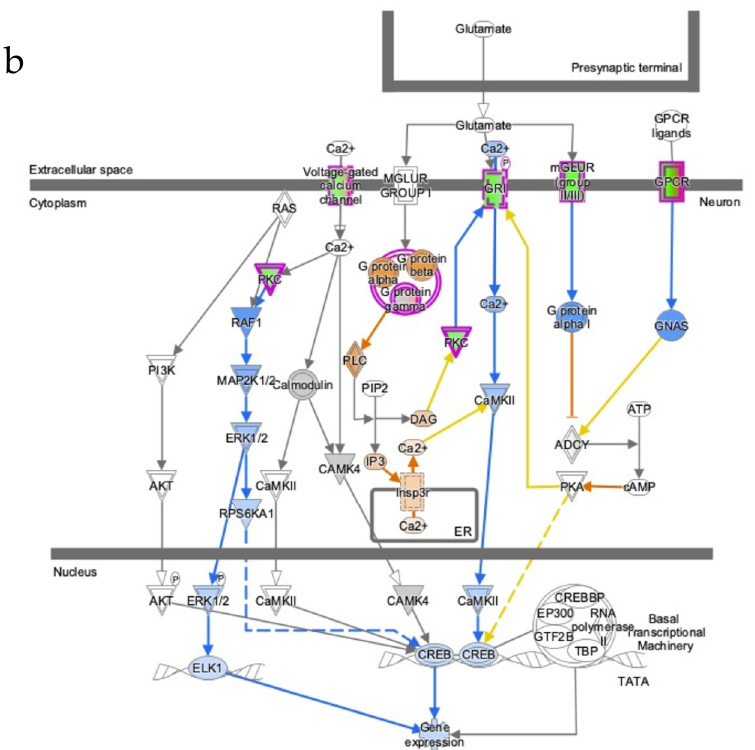
Figure 6. Glutamate receptor signaling and CREB signaling in neurons have generated with IPA.